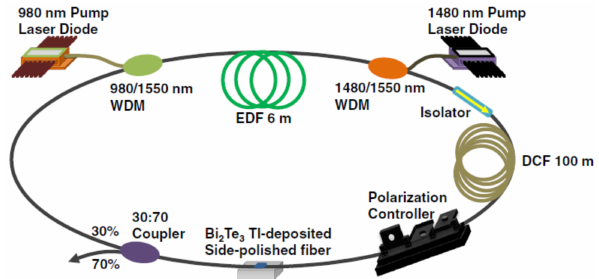
Figure 14. The fiber laser system for dissipative soliton resonance. Reprinted with permission from [75].